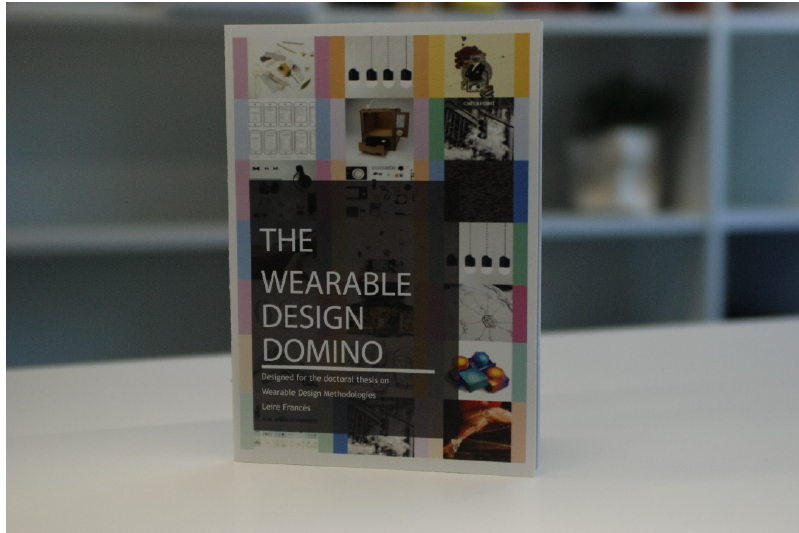
Figure 9. Photo of the We Co-Do